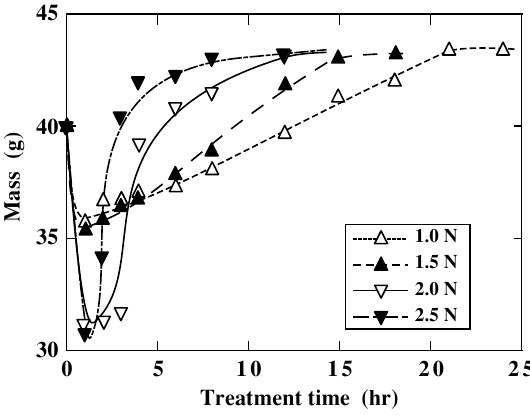
Fig. 5 Change in mass of products with treatment time for various NaOH